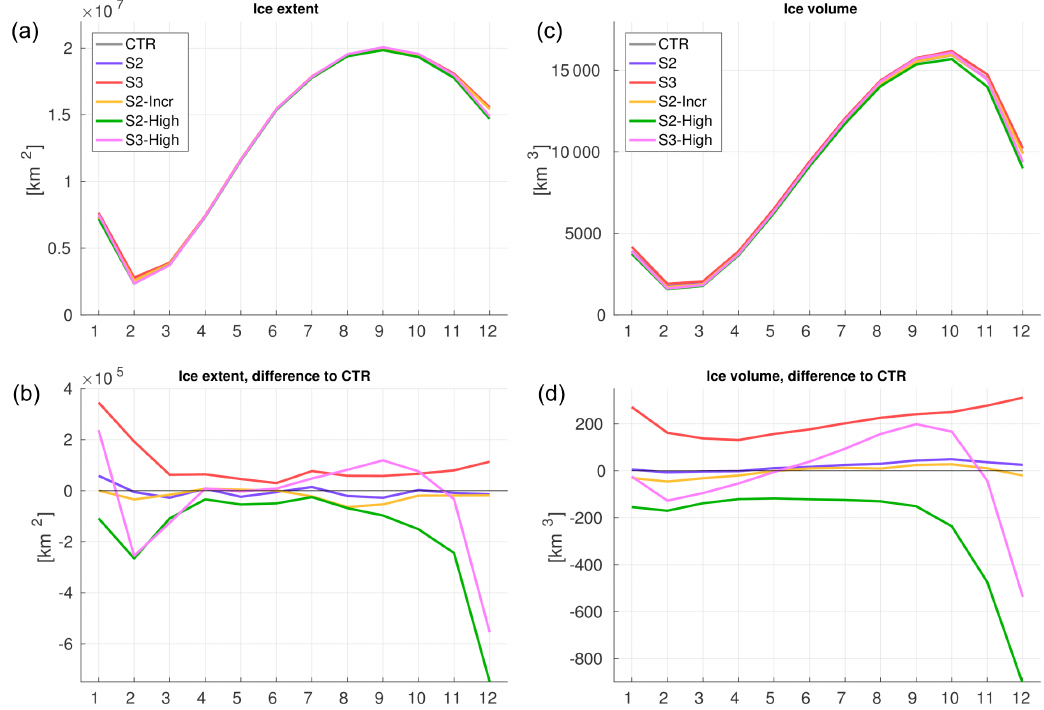
Figure 4. Mean seasonal cycle of (a) sea ice extent, (b) differences to CTR in sea ice extent, (c) sea ice volume, and (d) differences to CTR in sea ice volume for